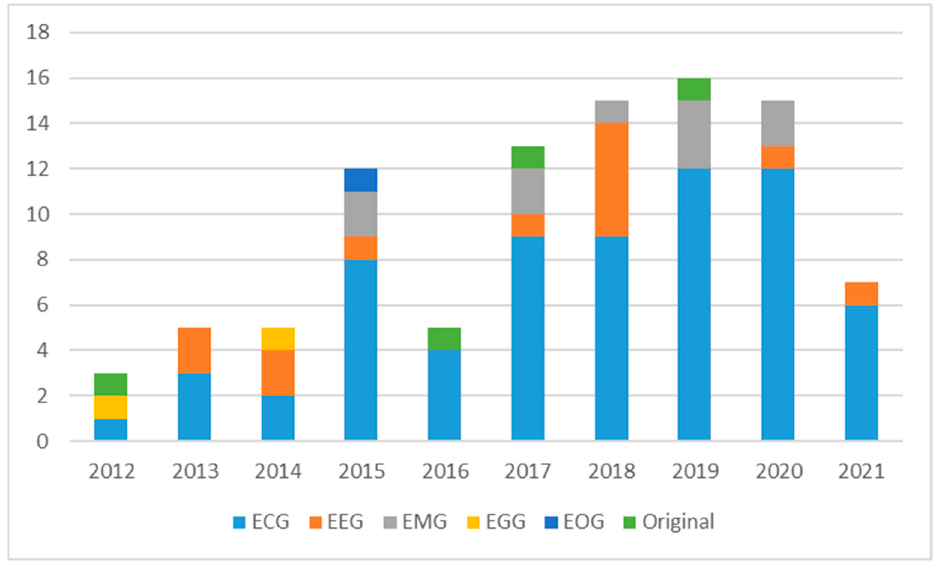
Figure 15. Number of articles devoted to the application of AFE chips by year from 2012 to 2021.